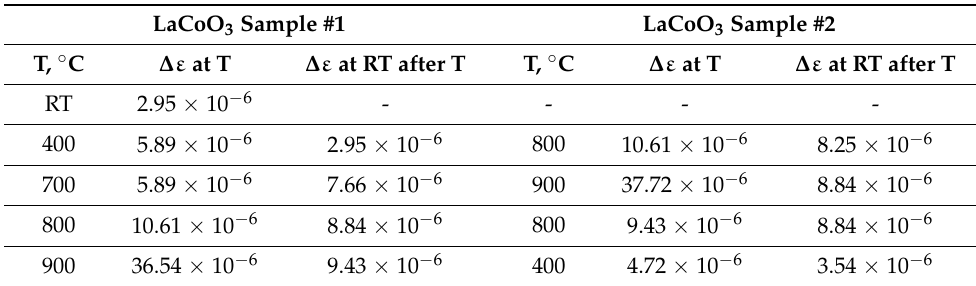
Table 3. The creep strain shift ∆ ε of two LaCoO 3 samples calculated at loading/unloading cycle 3 and loading cycle 4 at different